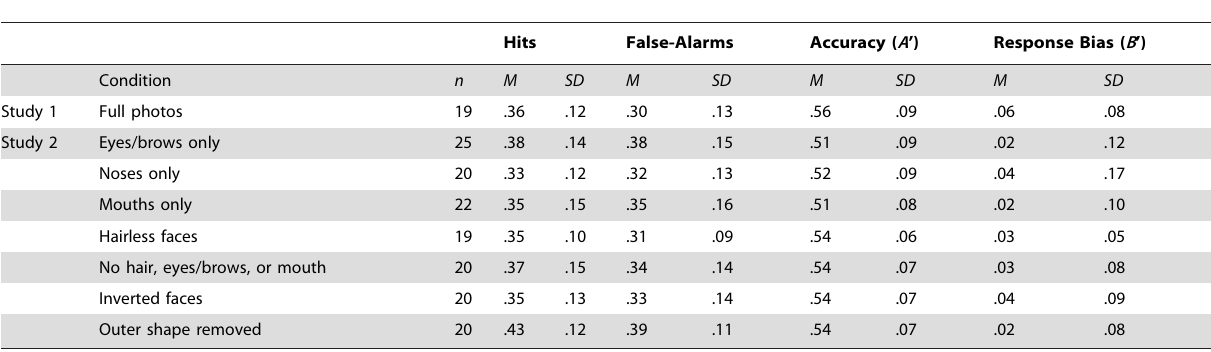
Table 1. Summary statistics for the signal detection analyses in Studies 1–2.